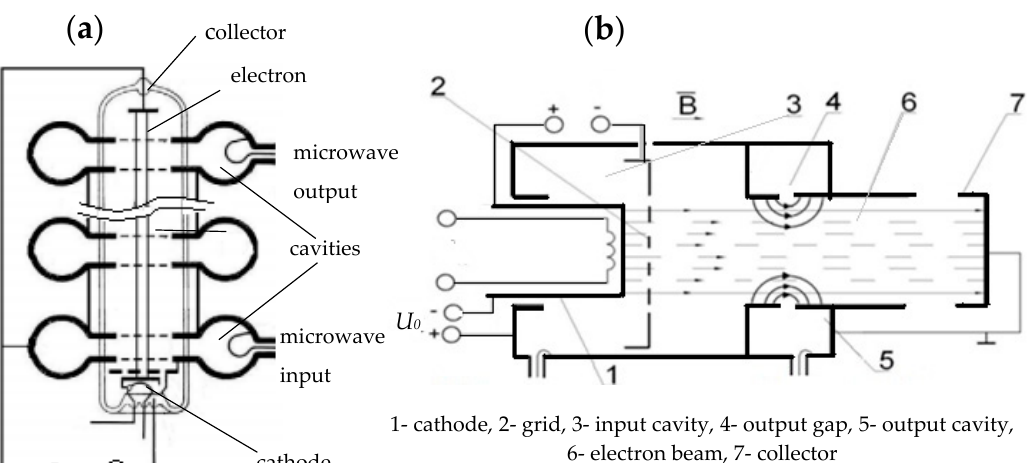
Figure 2. ( a ) Simplified schemes of klystrons and ( b ) IOTs.